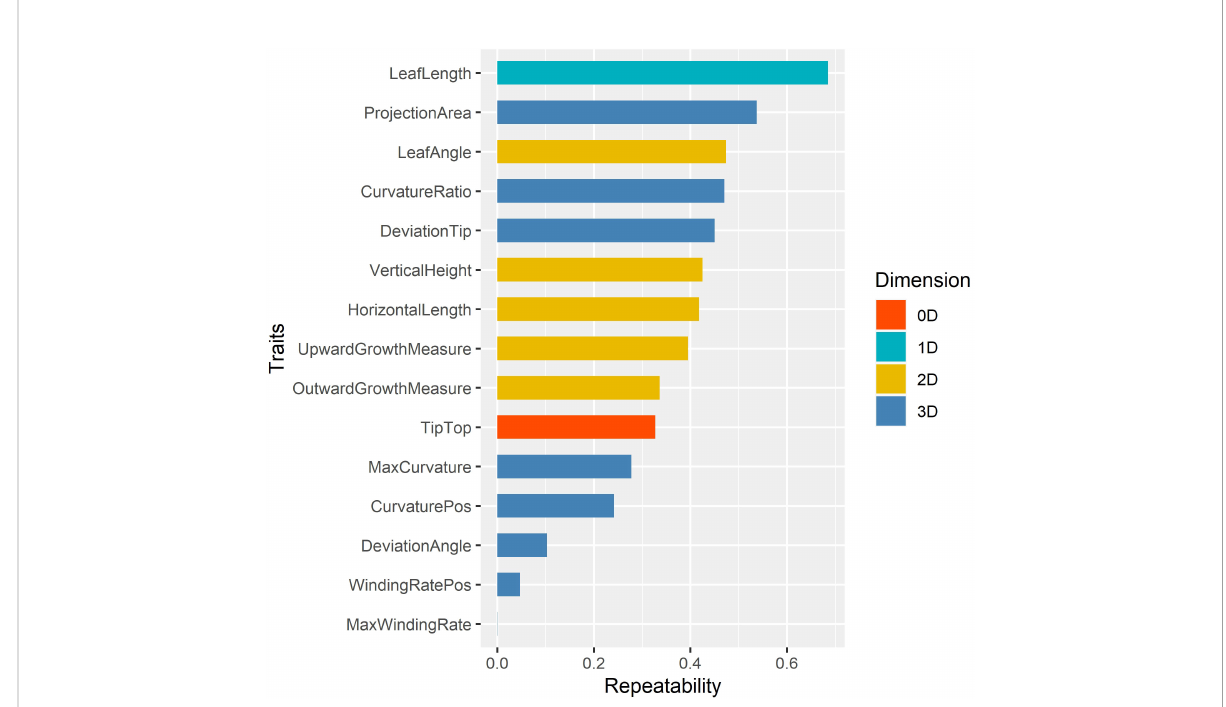
FIGURE 8 The repeatability of 15 leaf midrib curve traits. The traits are color-coded according to their